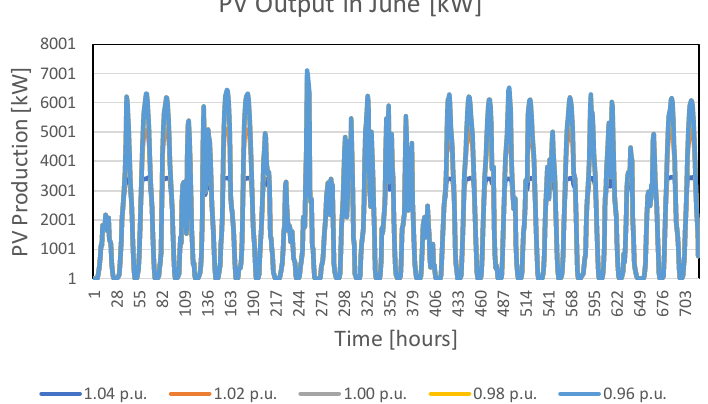
Figure 13. PV production time series for various CVR voltage setpoints.